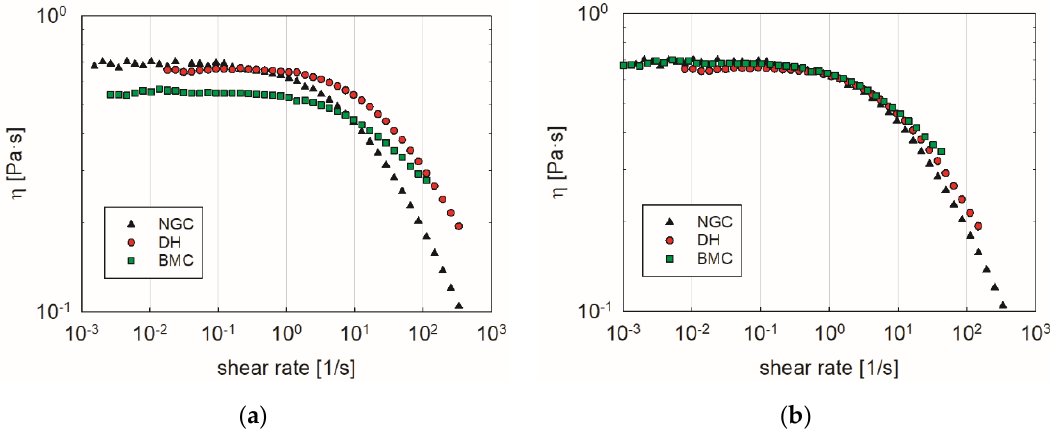
Figure 6. The viscosity of the HydroxyEthyl Methyl Cellulose (HEMC) aqueous solution as a function of shear rate for the NGC and the two complex geometries. ( a ) Results obtained by using the c SS and c SR coefficients provided by Anton Paar; ( b ) Results obtained by using the c SS and c SR coefficients from the Couette analogy.